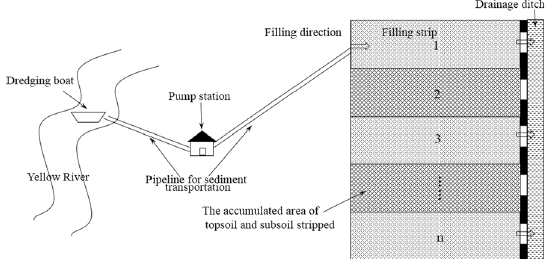
Fig. 3 Single filling diagram of a fill using Yellow River sediments with alternating strips